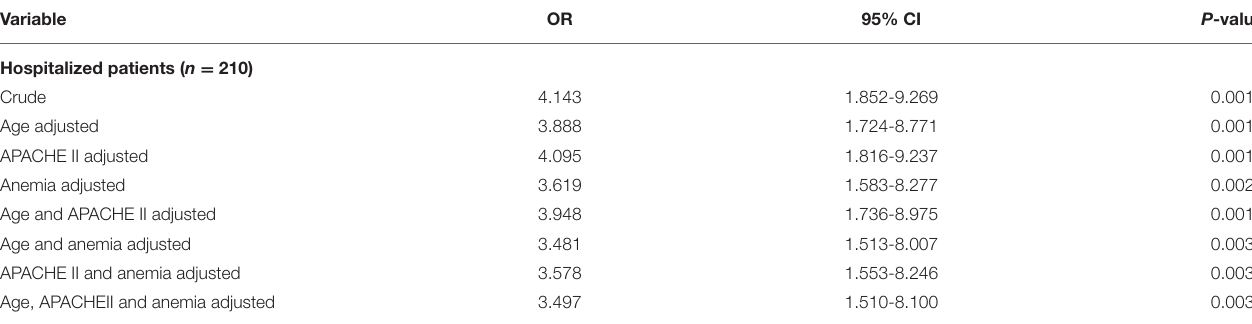
TABLE 4 | ORs and 95% CI of H. pylori positive on NTIS prevalence. Variable